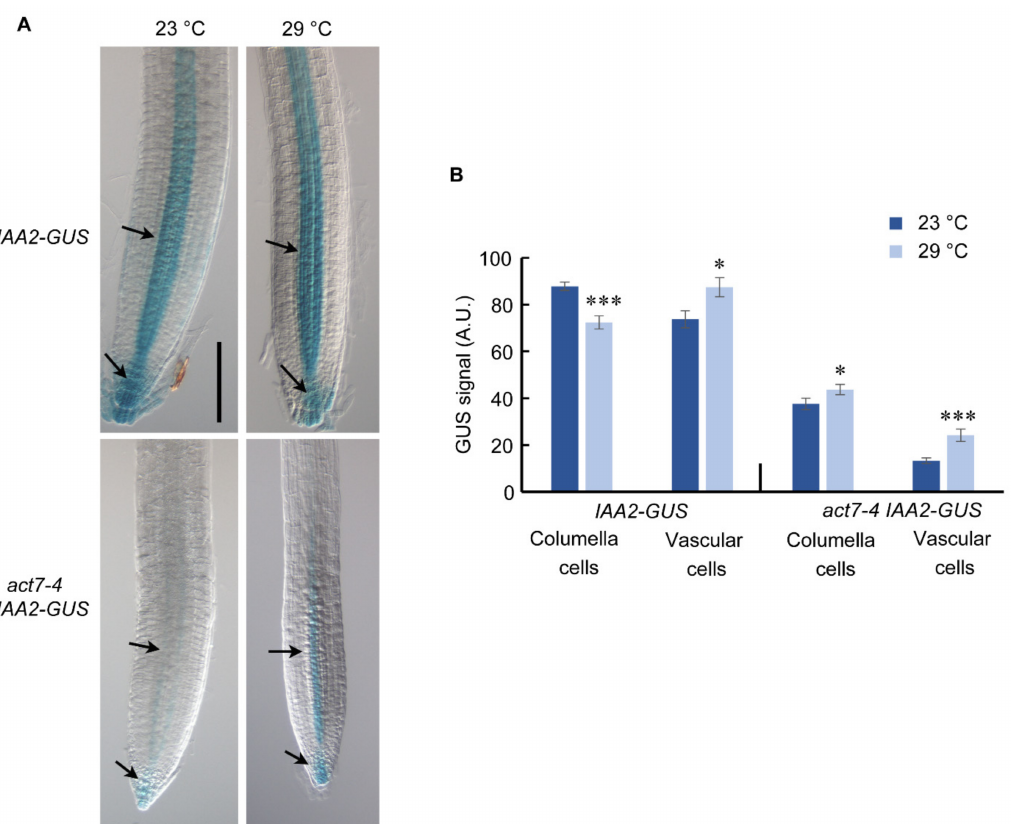
Figure 6. Prolonged high temperature alters the auxin response in Col-0 and act7-4 roots. ( A ) IAA2::GUS and act7- 4XIAA2::GUS at 23 and 29 ◦ C. Five-day-old IAA2::GUS and act7-4XIAA2::GUS seedlings were transferred to 23 and 29 ◦ C for 72 h. Seedlings were stained in a buffer containing 1 mM X-gluc for 1 h at 37 ◦ C and cleared for photography. These are representative images stained in at least three separate experiments. Bar = 100 µ m. ( B ) Quantification of GUS signal in the root from ( A ). Asterisks represent the statistical significance between the means for genotype specific treatment judged by the Student’s t -test (* p < 0.05 and *** p < 0.001). Vertical bars in the graph represent mean ± SE of the 15–20 seedlings from at least three independent